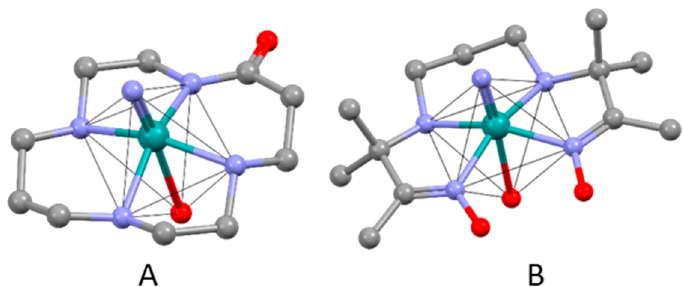
Figure 6. Structures of six-coordinated [TcN(O–cyclam)(OH 2 )] + ( A ) and [TcN(pnao)(OH 2 )] + ( B